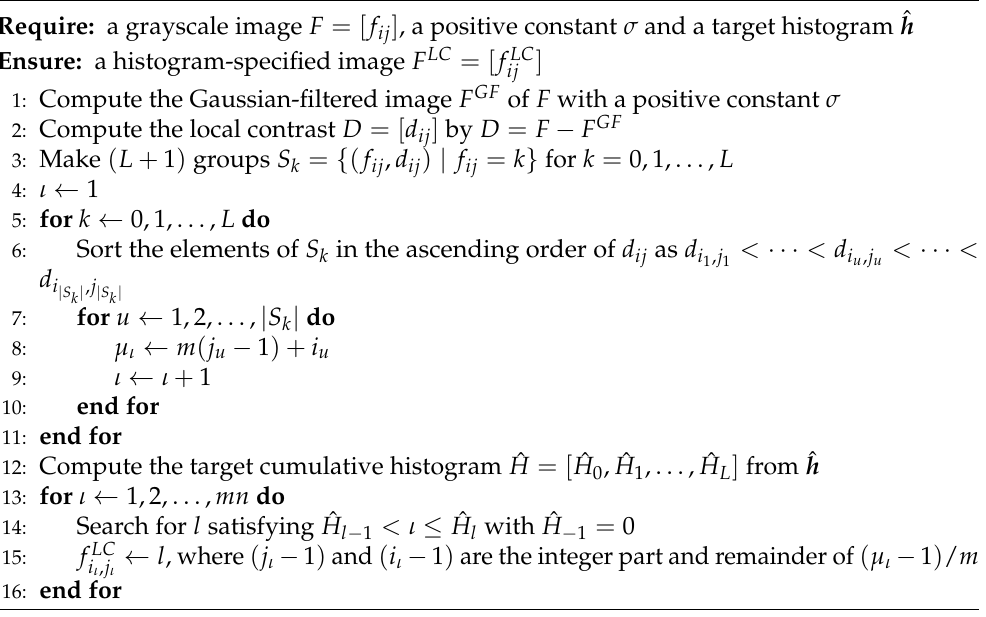
Algorithm 2 Local contrast-based exact histogram specification